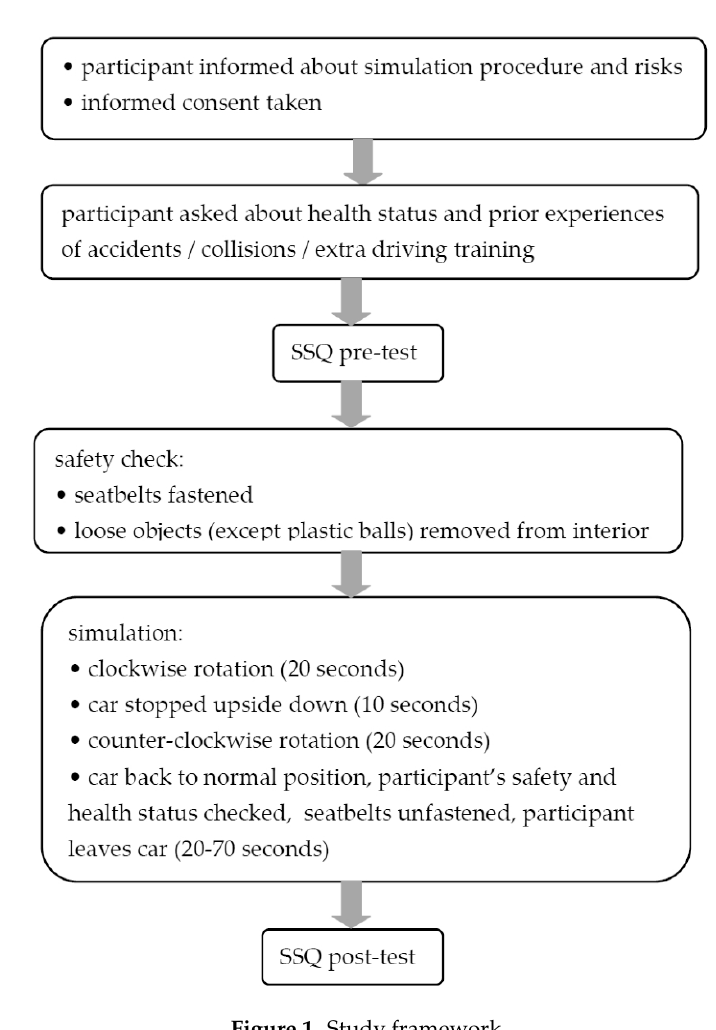
Figure 1. Study framework.